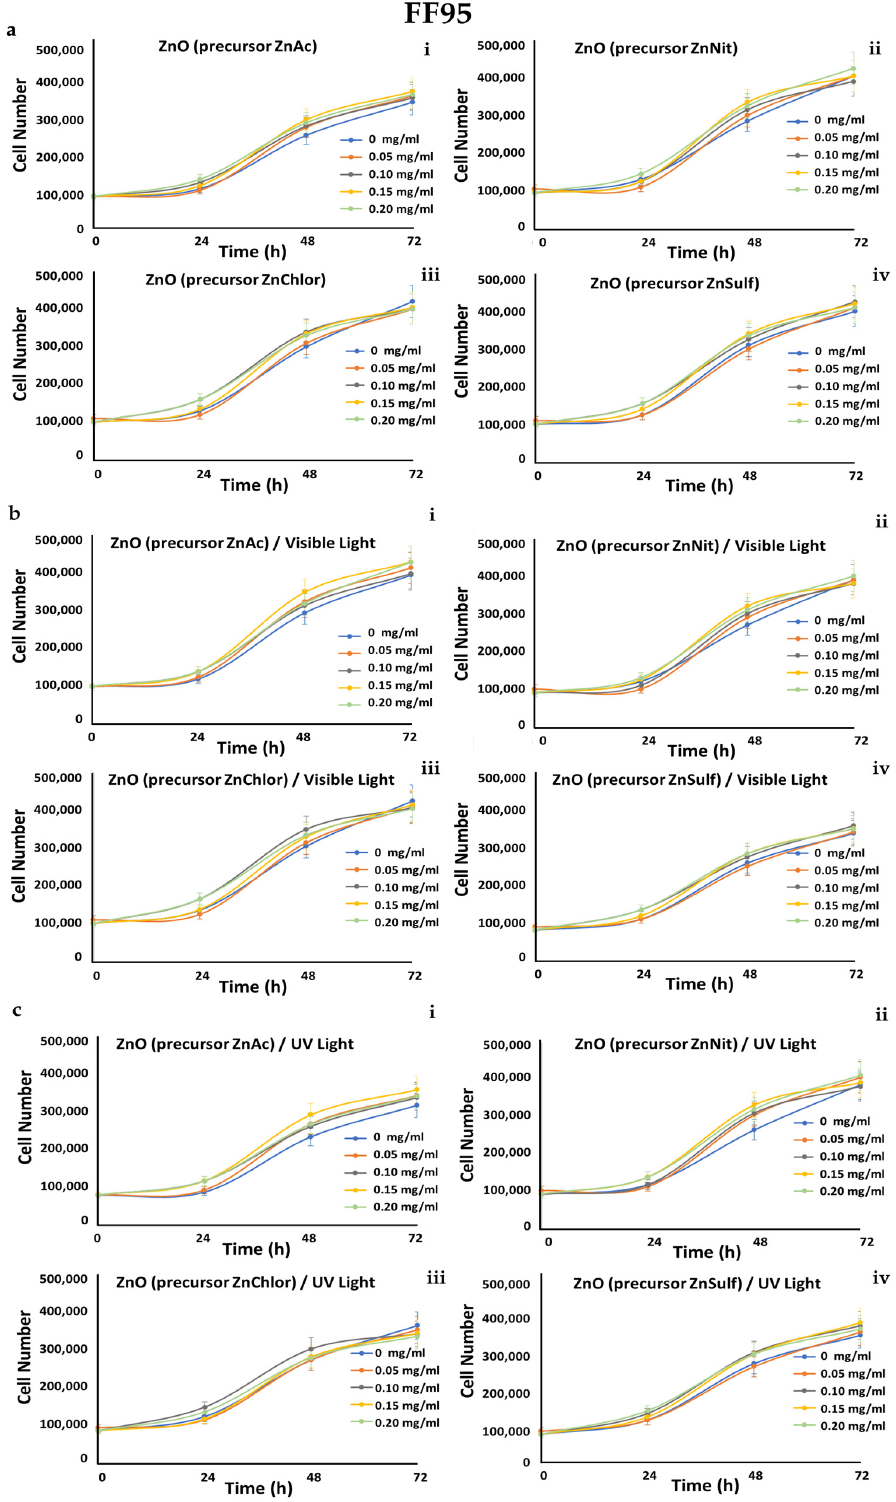
Figure 19. Growth rates of FF95 cell line in the presence of ( a ) zinc acetate dehydrate (ZnAc), zinc nitrate hexahydrate (ZnNit), zinc chloride (ZnChlor), zinc sulphate heptahydrate (ZnSulf). ( b ) Photo-activated with visible light ZnAc, ZnNit, ZnChlor, and ZnSulf. ( c ) Photo-activated with UV light ZnAc, ZnNit, ZnChlor, and ZnSulf. There is not any significant effect on cell proliferation. p < 0.05 was considered statistically significant.